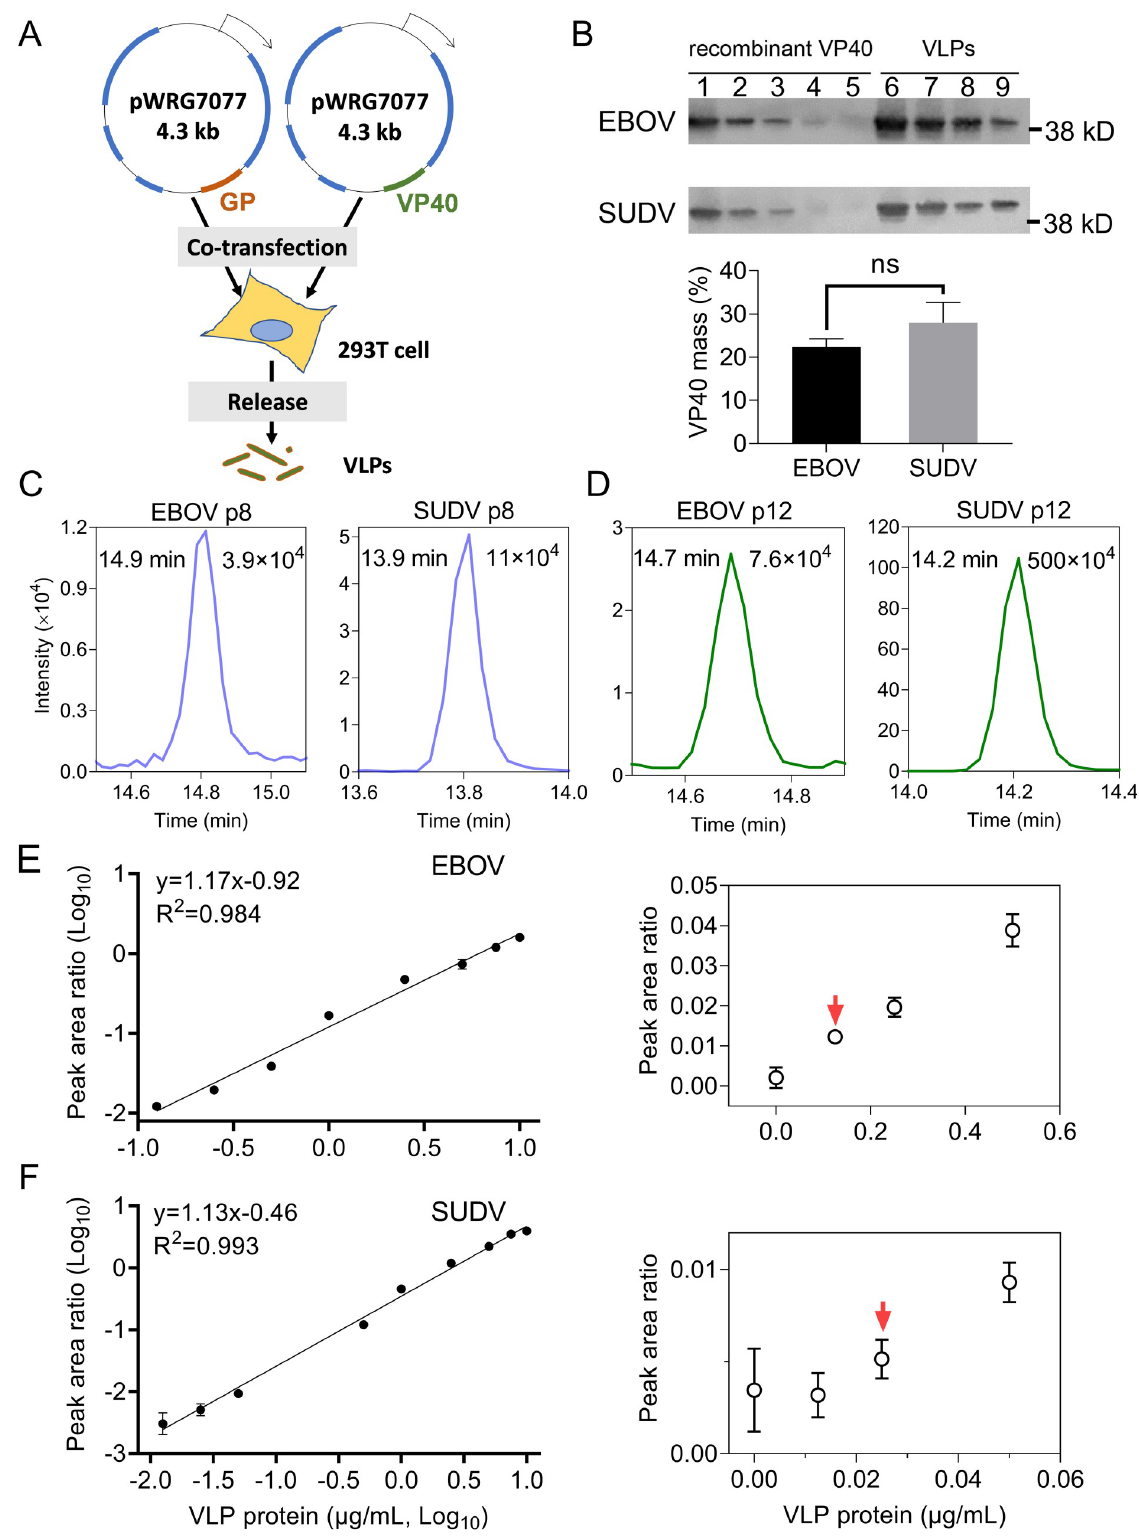
Fig 4. Species-specific VLP used for VP40 quantification. (A) Generation of VLPs by co-transfecting 293T cells with pWRG7077 plasmid containing VP40 (orange) and the plasmid containing GP genes (green) from ebolavirus. (B) Western blot quantification of VP40 content